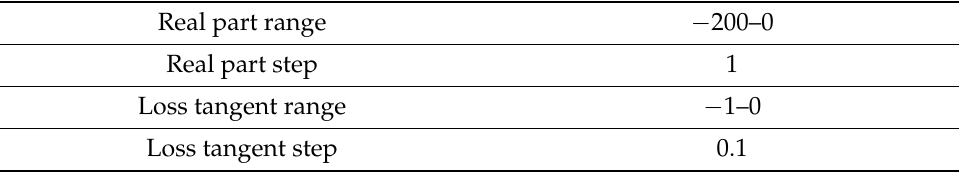
Table 1. Parameter scan Figure 3. Schematic of cavity.